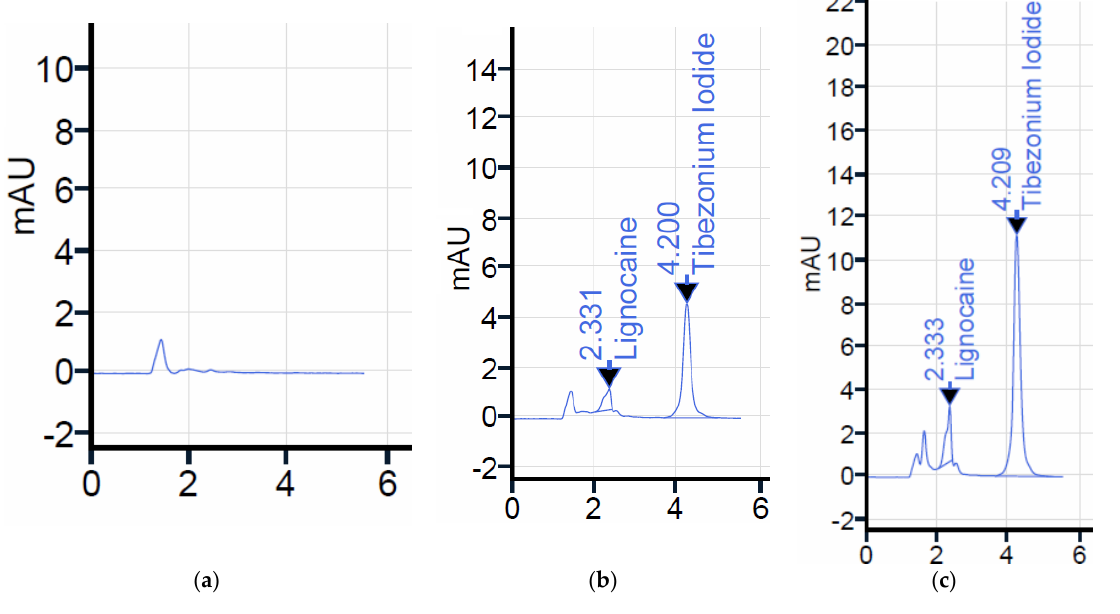
Figure 2. Chromatograms indicating ( a ) placebo dosage form depicting SLS peak, ( b ) drug peaks in the PBS, pH 6.8 and ( c ) human salivary sample analysis. The peaks of drugs in human salivary samples revealed no interacting peaks of the ingredients with that of the drugs. This confirms